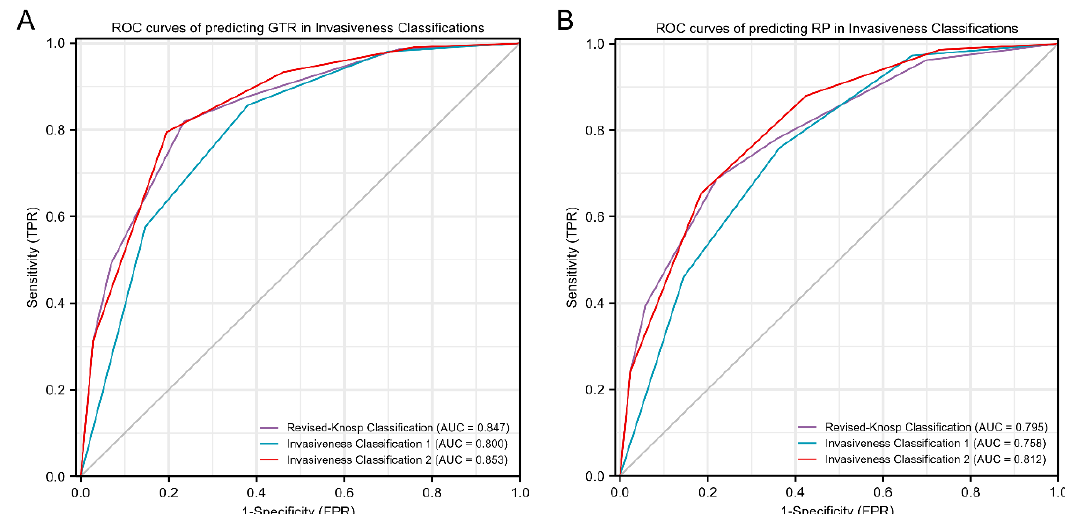
Figure 8. Receiver operator characteristic (ROC) analysis of gross-total resection (GTR) and recurrence/progression (RP). ROC curves of predicting GTR in revised-Knosp classification, Invasiveness Classification 1, and invasiveness classification 2 ( A ). ROC curves of predicting RP for revised-Knosp classification, Invasiveness Classification 1, and Invasiveness Classification 2 ( B ). CI: Confidence Interval; FPR: False Positive Rate; TPR: True Positive Rate.